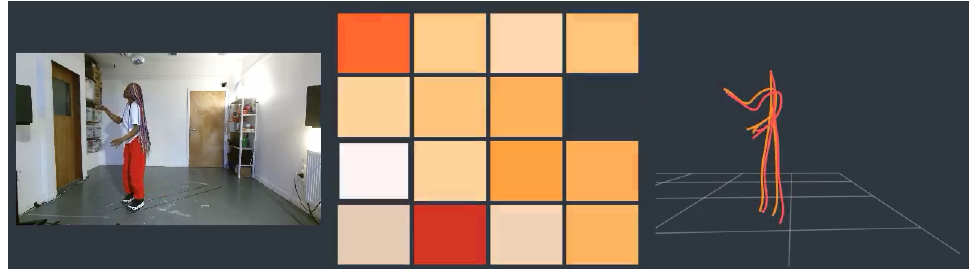
Figure 3. User interface of custom software implementing the latent mapping. The left image shows the RGB camera feed. The right image shows the tracked skeleton in orange, and the skeleton as reconstructed by the VAE decoder in red. The central matrix visualises the current latent mapping (16 values).